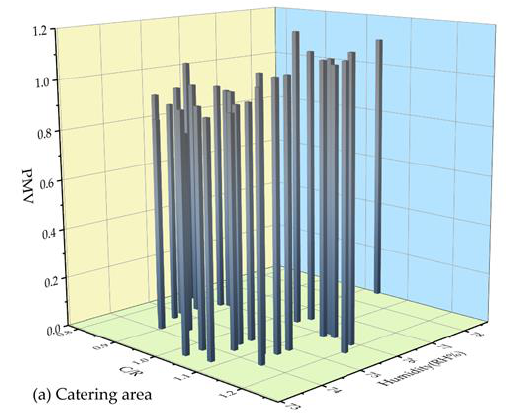
Figure 15. Convection – radiation heat dissipation ratio in different functional